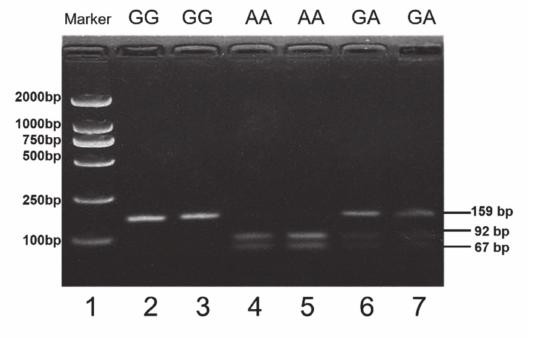
Figure 3. Agarose gel electrophoresis of three genotypes in SNP6 locus within deleted in azoospermia-like (DAZL ) gene . Table 3. Genotypic and allelic frequencies, expected heterozygosity (He), e ff ective allele number (Ne), polymorphism information content (PIC), Hardy–Weinberg equilibrium (HWE) testing p value of single nucleotide polymorphisms (SNPs) identified in DAZL